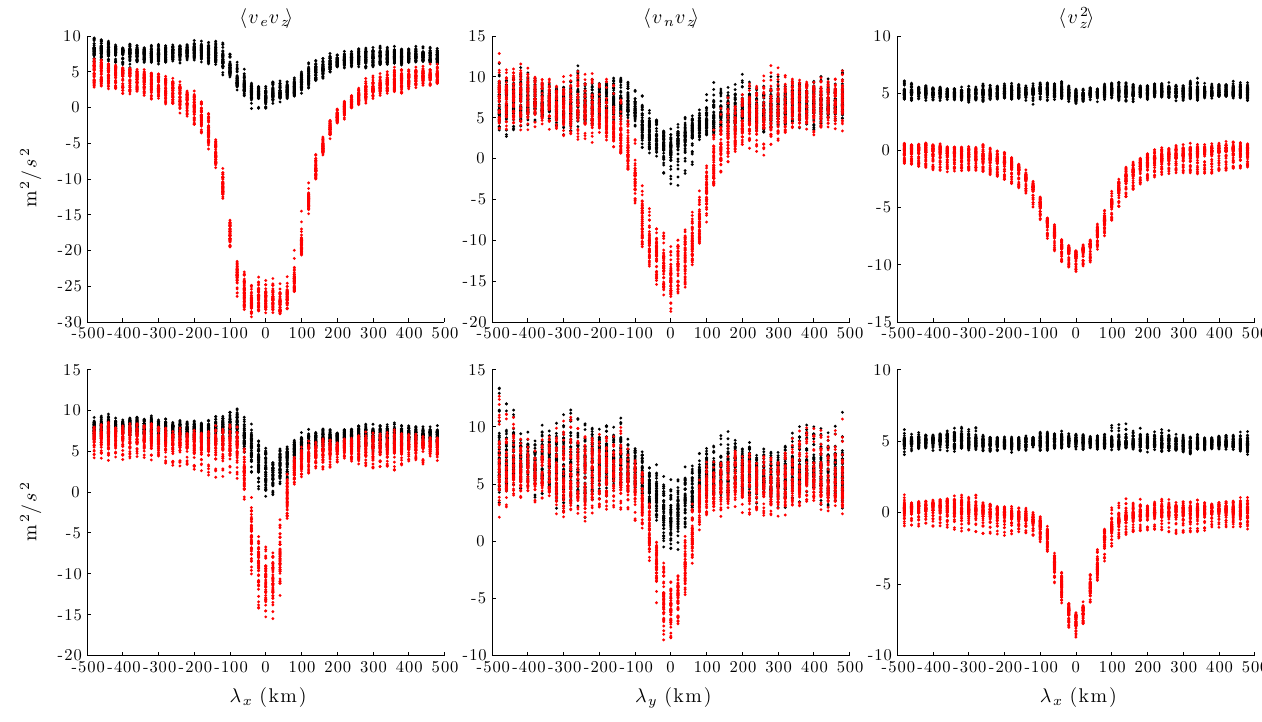
Fig. 6. Biases in the momentum fluxes and vertical velocity variance as a function of horizontal wavelength for beam map #1 (see Table 1) (top row) and beam map #2 (bottom row). Black curves show the solutions with only the variance terms included in the estimator, and red terms show results including the full covariance matrix. Simulations are with σ e = 2ms − 1